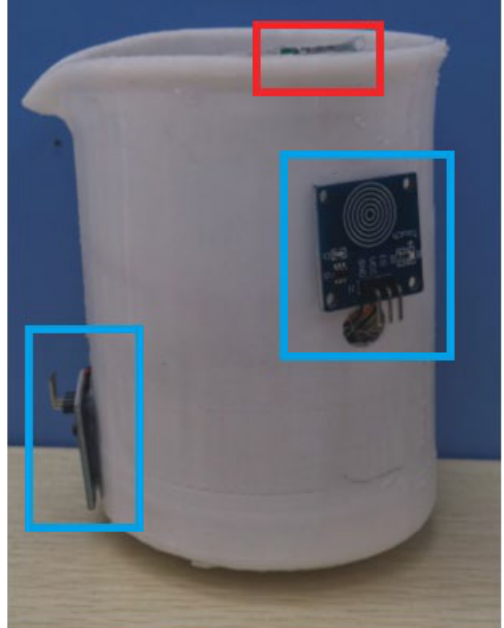
Figure 5. Intelligent